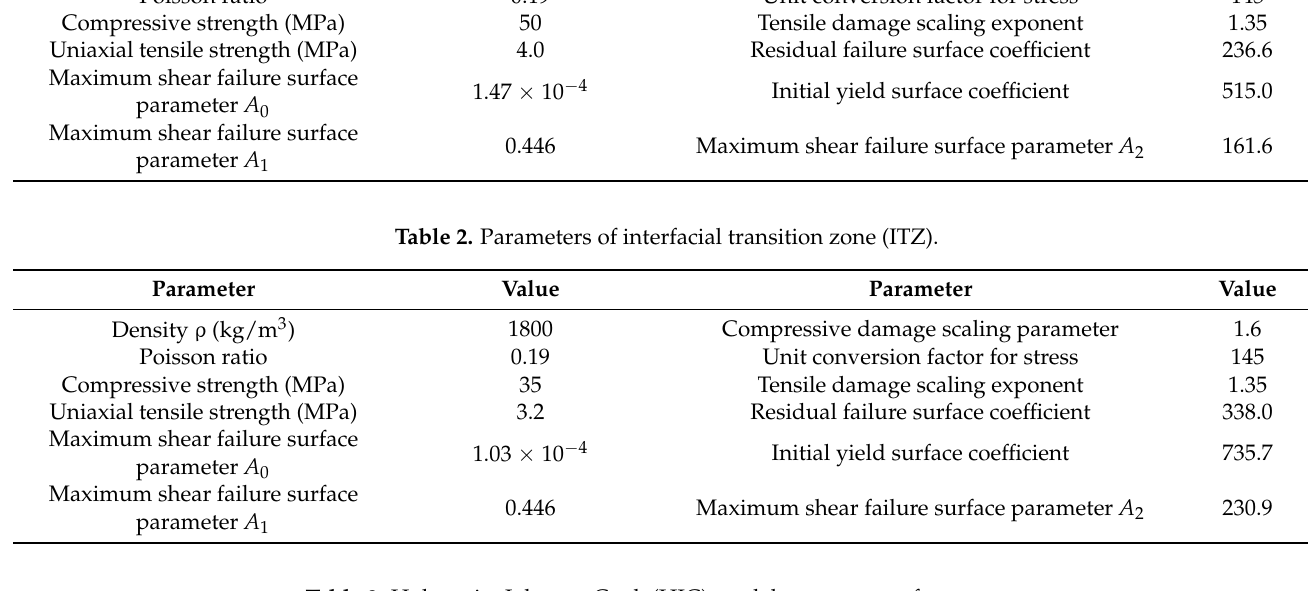
Table 3. Holmquist-Johnson-Cook (HJC) model parameters of